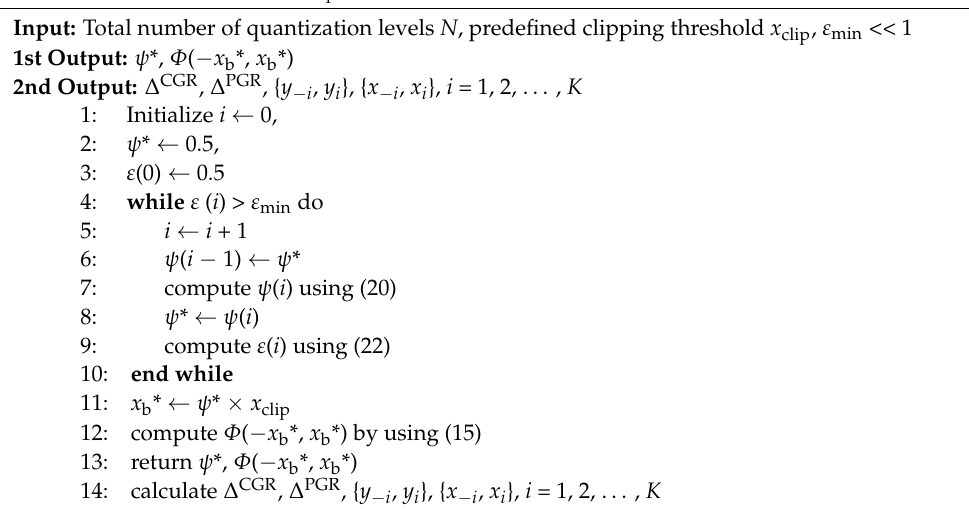
Algorithm 1. PWUQ Laplacian ( N , x clip , ε min )—iterative parameterization of PWUQ for the Laplacian pdf and the given x clip —determining ψ * and Φ ( − x b *, x b